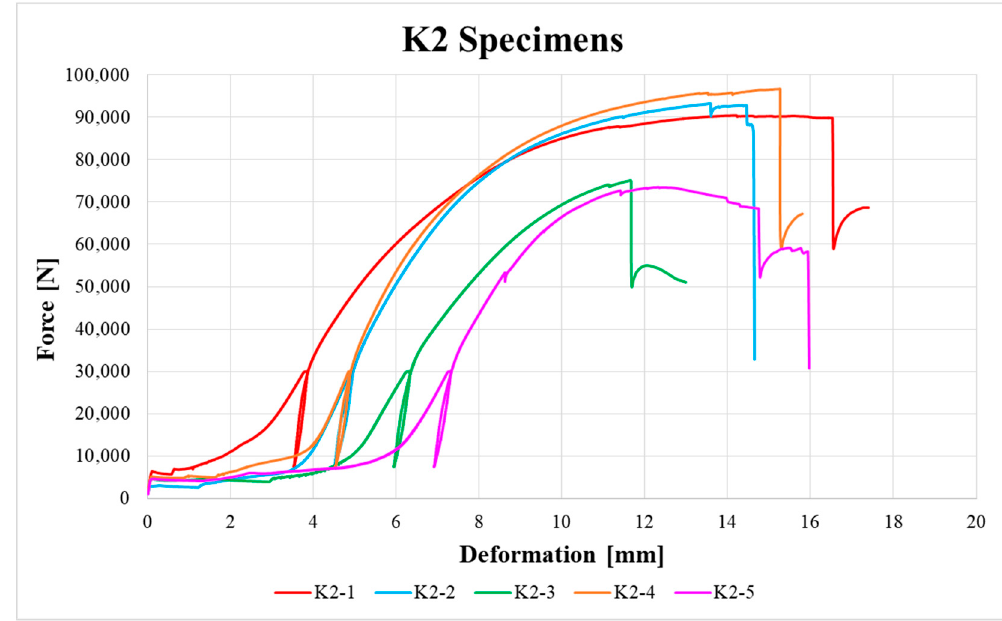
Figure 13. Load–deformation curves of K2 specimens.